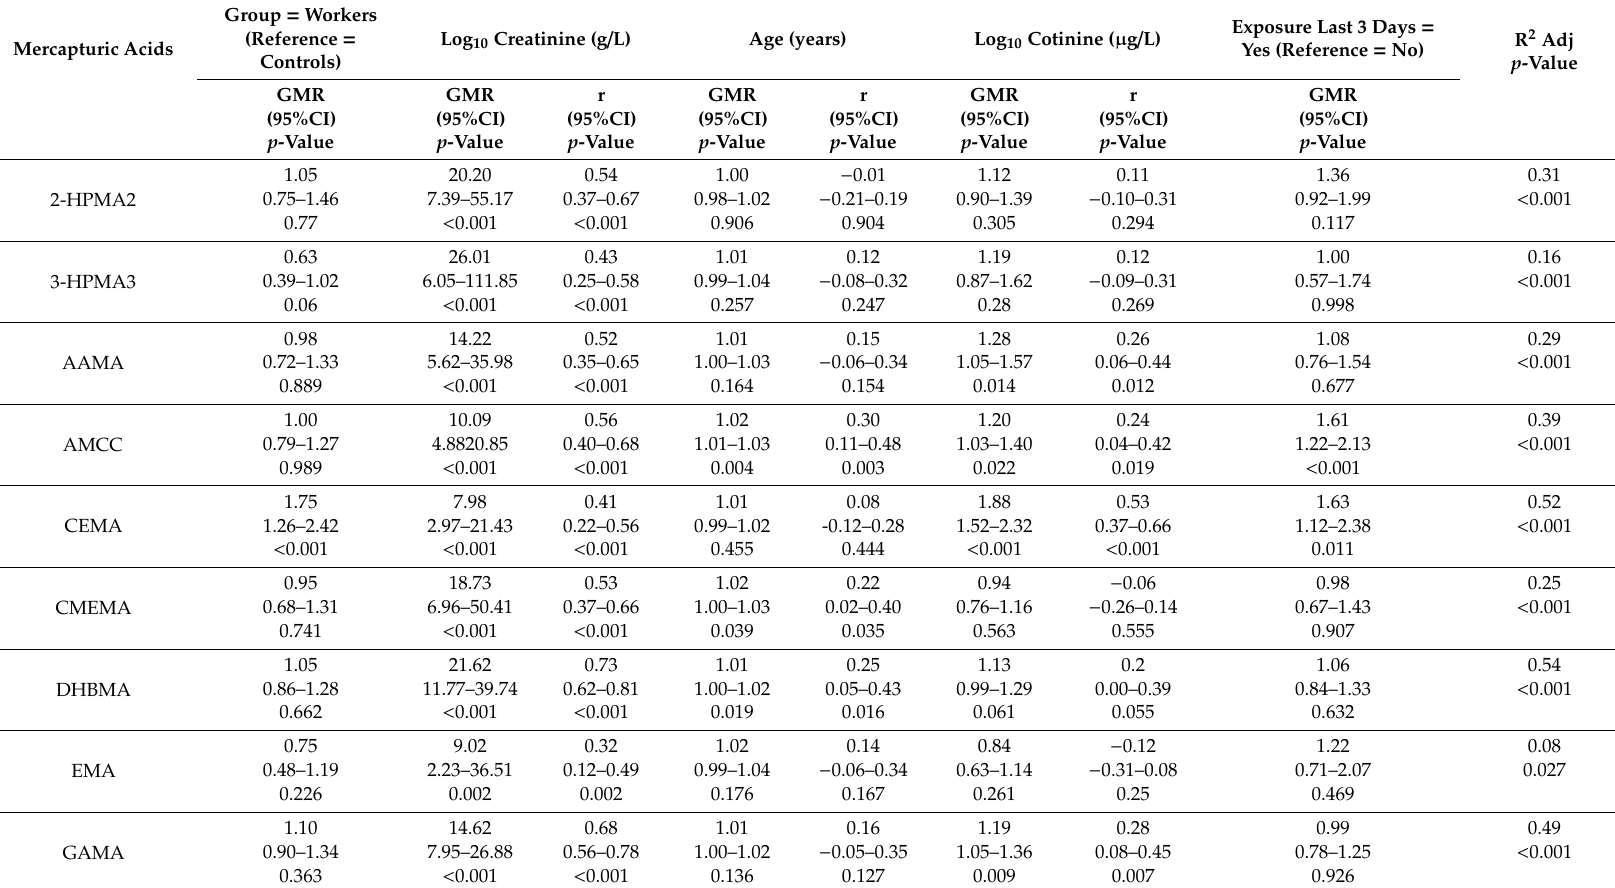
Table 3. Results of the linear models built to evaluate the di ff erences between controls and workers. The dependent variable of each linear model was the log 10 -transformed value of a mercapturic acid ( µ g / L). The independent variables were study group (controls or workers), log 10 creatinine (g / L), age (years), log 10 cotinine ( µ g / L), hobbies at home involving exposure during the last 3 days (no or yes) ( n = 94, four observations removed due to missing